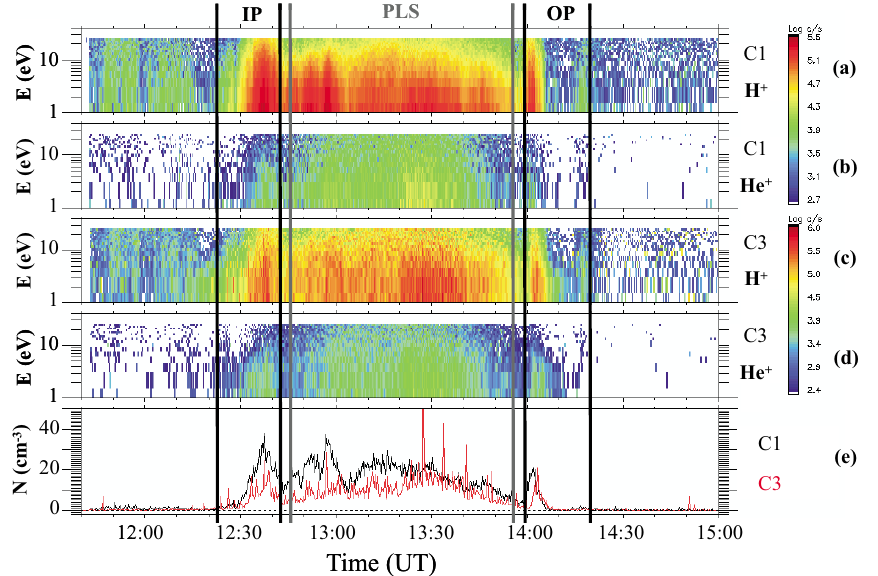
Fig. 10. Data from the CIS instrument in RPA mode on 2 June 2002 during the plasmasphere crossing of C1 and C3. Panels (a) and (b) show the distribution of H + and He + for C1, whereas the same data for C3 are shown on panels (c) and (d) . Panel (e) shows H + density for C1 (black) and C3